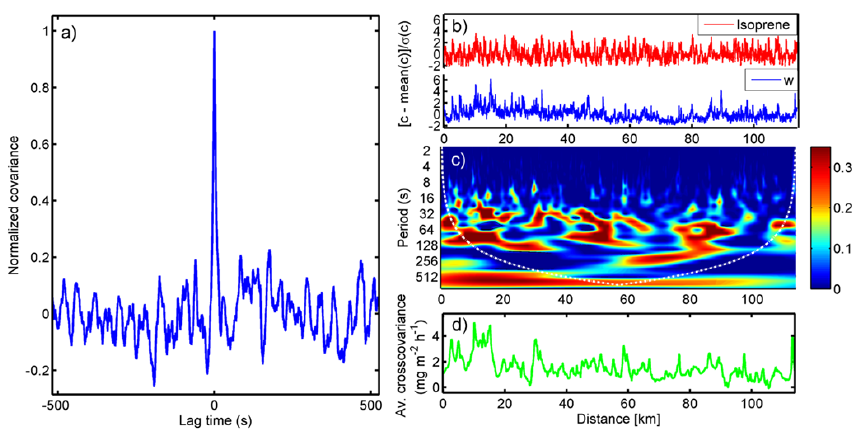
Figure 2. Flux quality control for an example flight leg (the segment from Supplement Fig. S2). (a) Clear peak in the covariance function, (b) variances of vertical wind speed ( w ) and isoprene, (c) time-resolved wavelet co-spectra, and (d) average cross-variance.